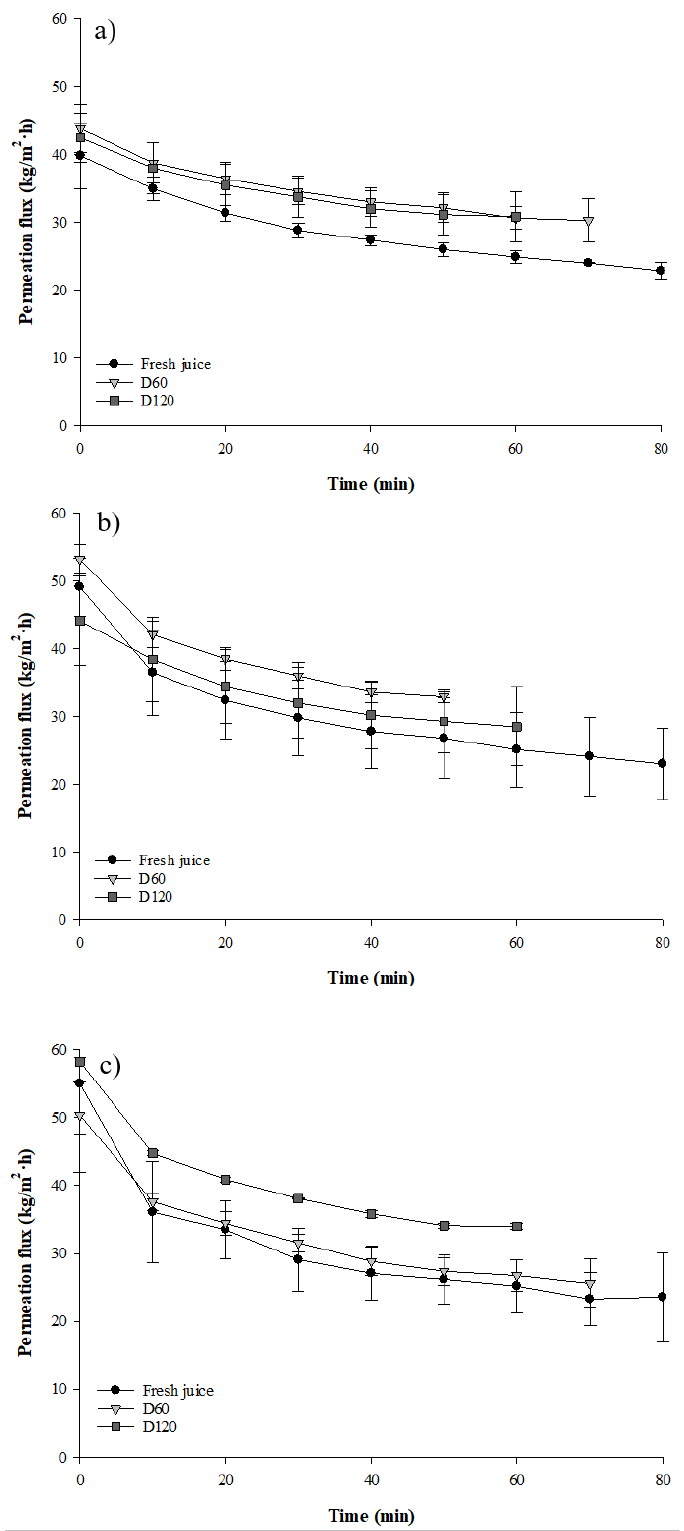
Figure 2. Evolution of permeation flux (kg/m 2 ·h) of fresh and depectinized (D60 and D120) cranberry juices during clarification by UF with membrane MWCO of ( a ) 50 kDa, ( b ) 100 kDa and ( c ) 500 kDa membranes.